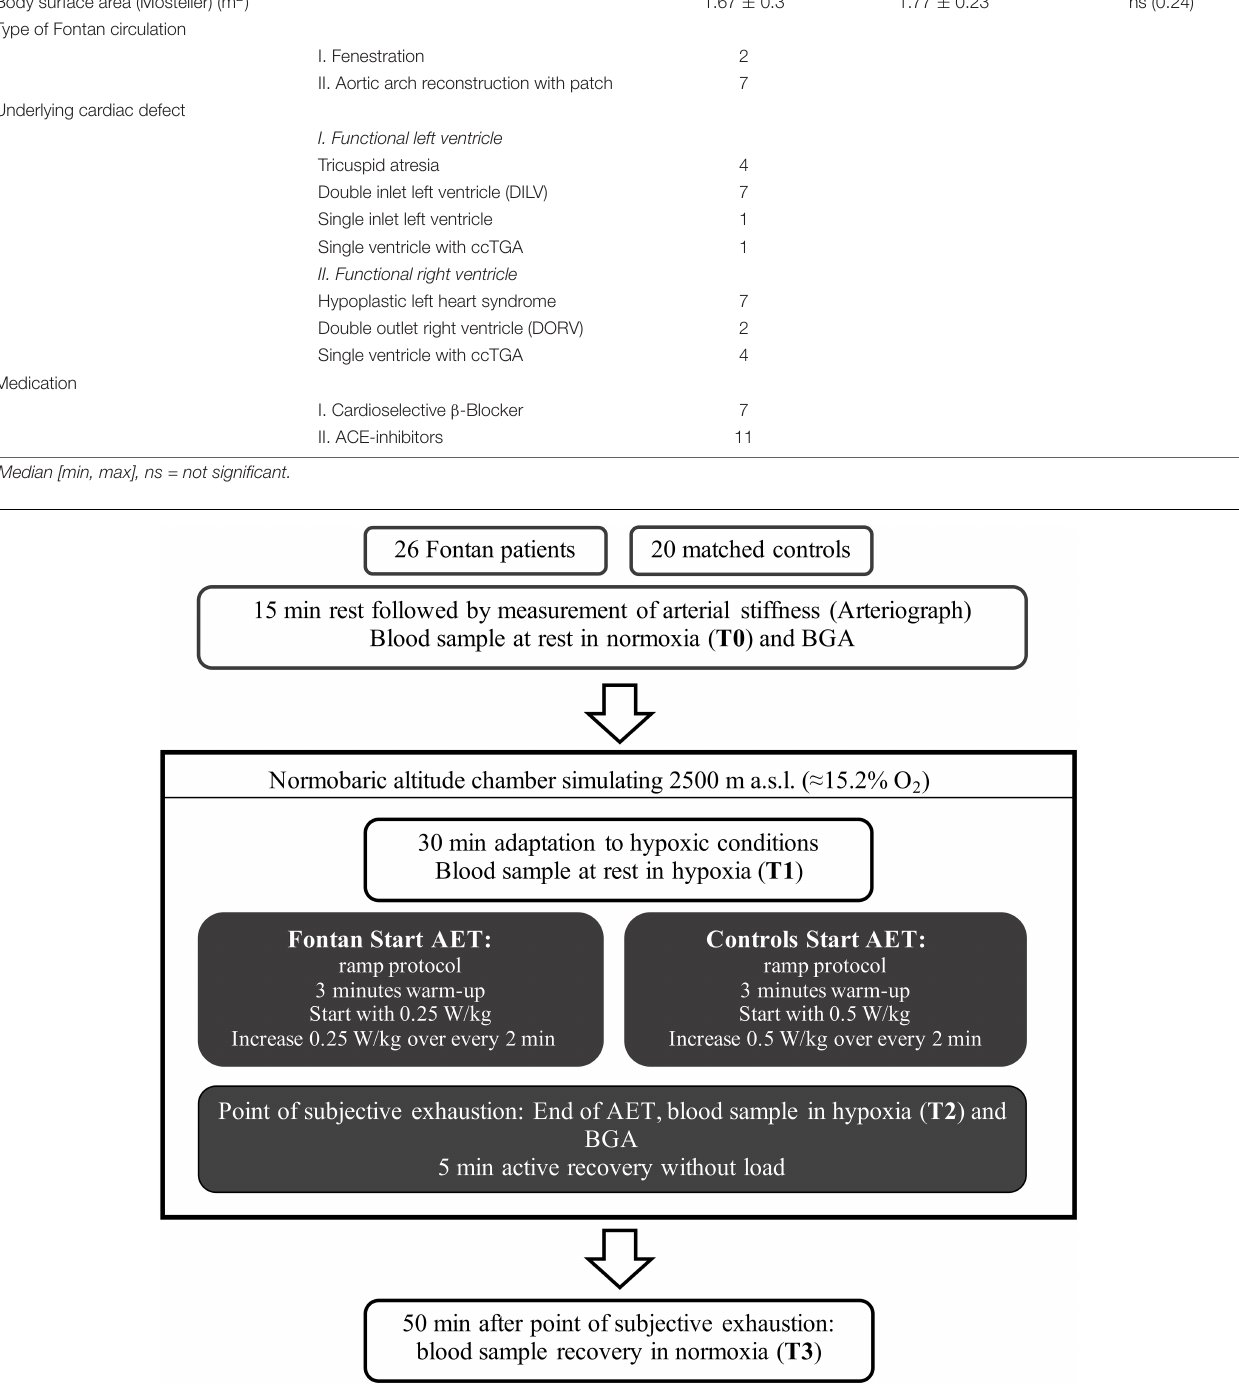
Frontiers in Physiology |